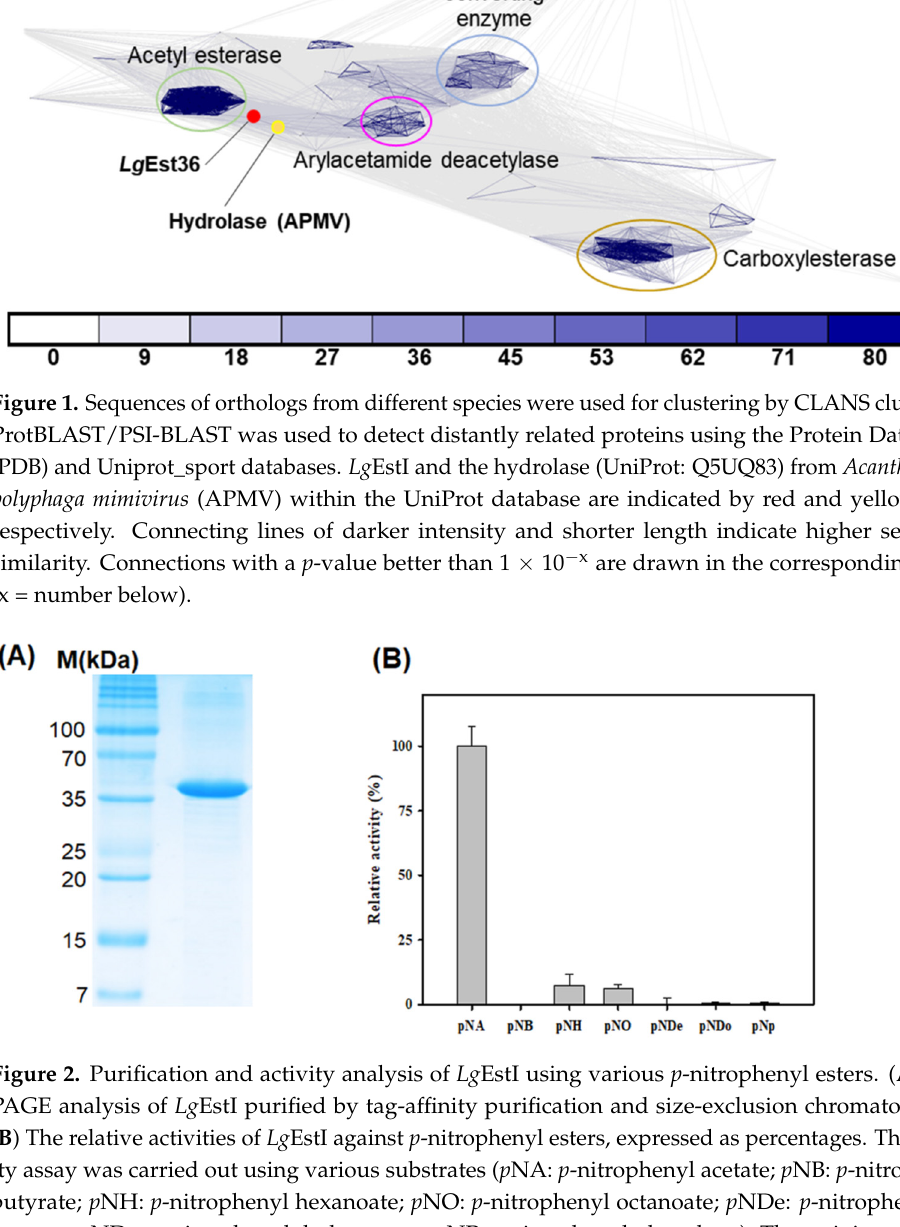
Figure 1. Sequences of orthologs from different species were used for clustering by CLANS cluster- ing. ProtBLAST/PSI-BLAST was used to detect distantly related proteins using the Protein Data Bank (PDB) and Uniprot_sport databases. Lg EstI and the hydrolase (UniProt: Q5UQ83) from Acan- thamoeba polyphaga mimivirus (APMV) within the UniProt database are indicated by red and yellow dots, respectively. Connecting lines of darker intensity and shorter length indicate higher sequence similarity. Connections with a p -value better than 1 × 10 –x are drawn in the corresponding color (x = number below).